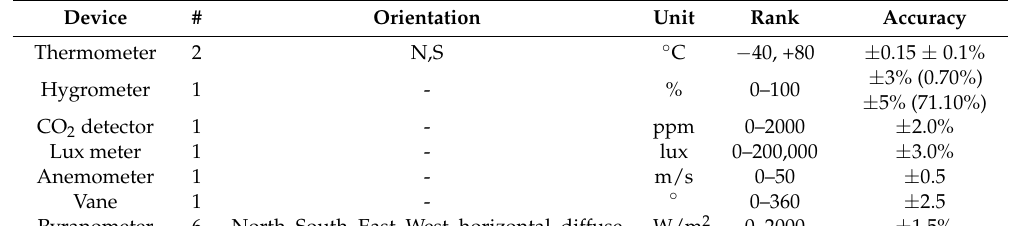
Table 4. Probes in the Weather Station.